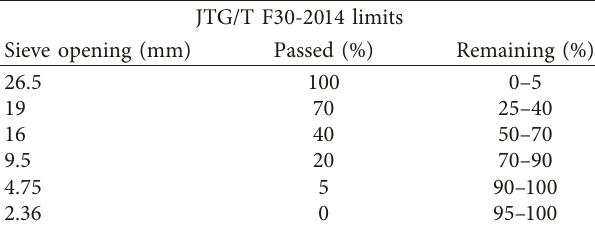
Table 2: Grading of coarse